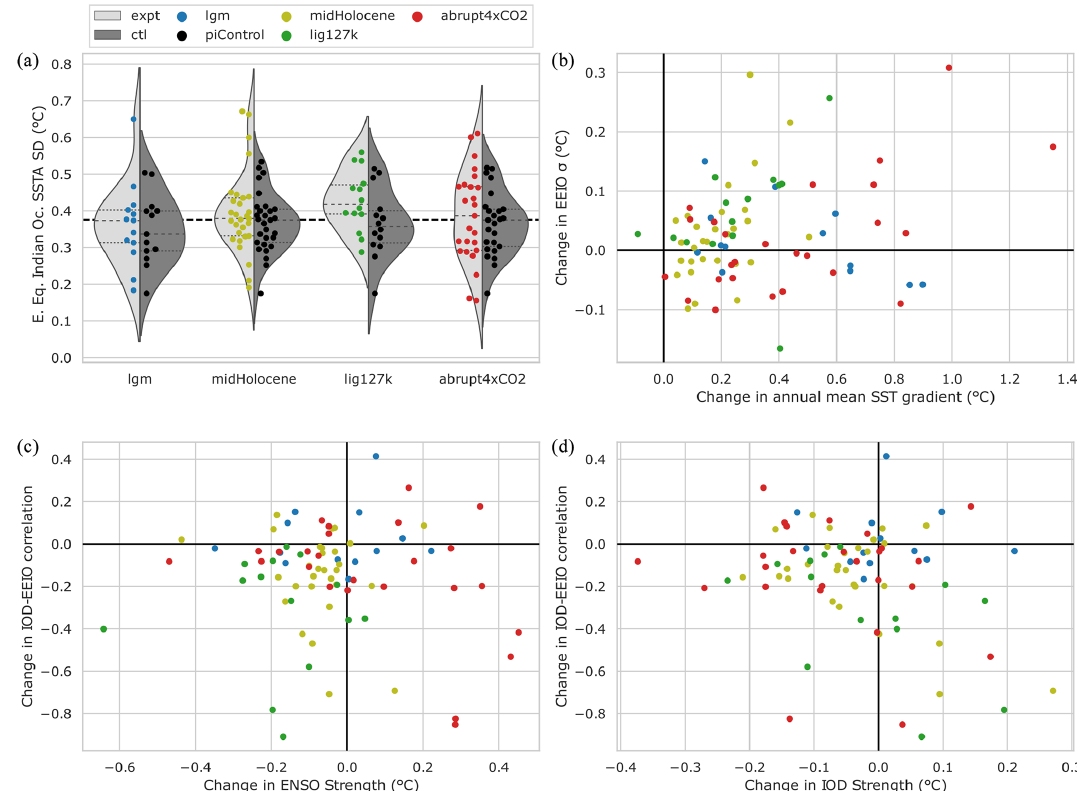
Figure 8. Response of Niño modes. (a) The amplitude of the Indian Ocean Niño-like mode is measured by the standard deviation of the eastern equatorial Indian Ocean SST anomalies (see Sect. 2.3 for definition). (b) The relationship between variability changes in the eastern equatorial Indian Ocean and the mean zonal gradient across the Indian Ocean, measured by the DMI. (c) The changes in the correlation coefficient between the two Niño modes, as a function of changes in the amplitude of Pacific ENSO. (d) The changes in the correlation coefficient between the Indian Ocean Dipole and the Indian Ocean Niño-like mode, as a function of changes in the amplitude of the Indian Ocean